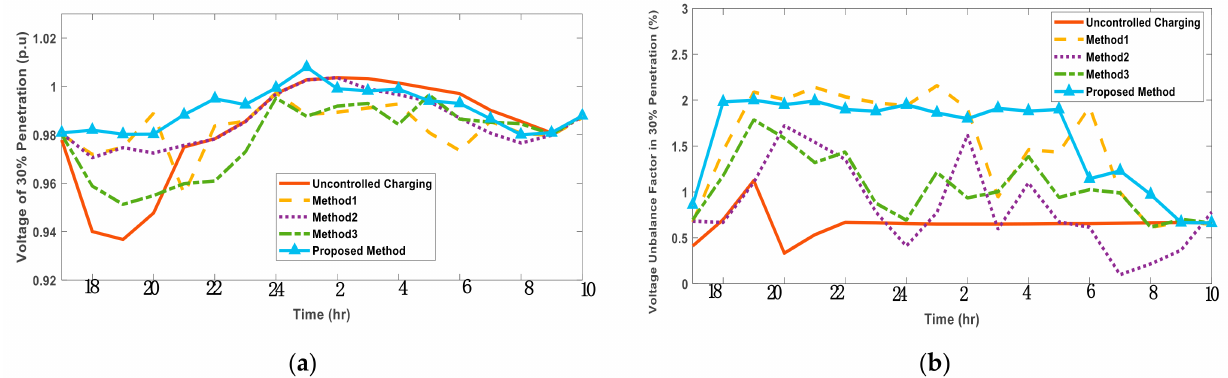
Figure 9. Bus 846 ( a ) voltage and ( b ) VUF under 30% EV